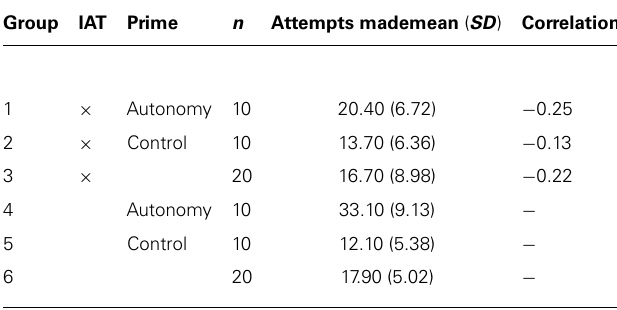
Table 1 | Descriptive statistics and participants in each group and correlations between IAT-completing groups, and number of attempts